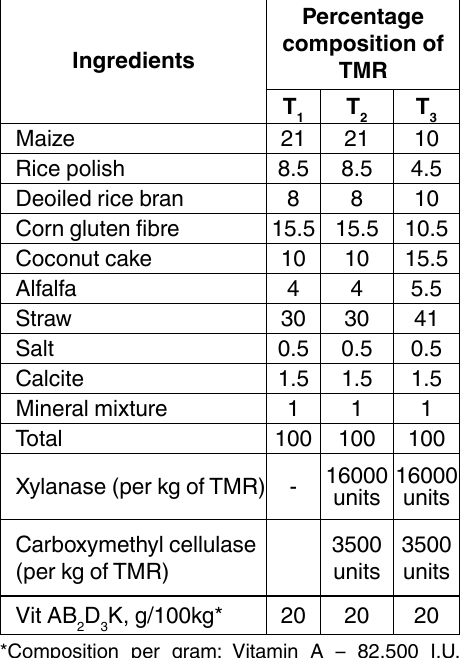
Table 1. Ingredient composition of TMR offered